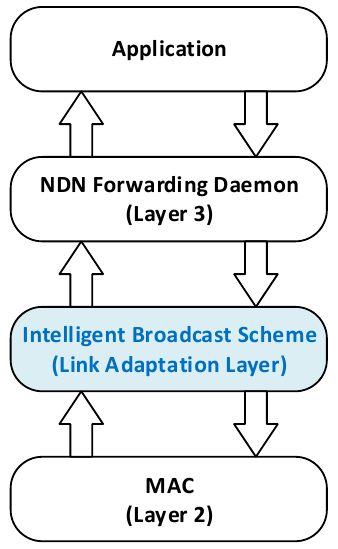
Figure 3. Ad-Hoc Named Data Networking (NDN)